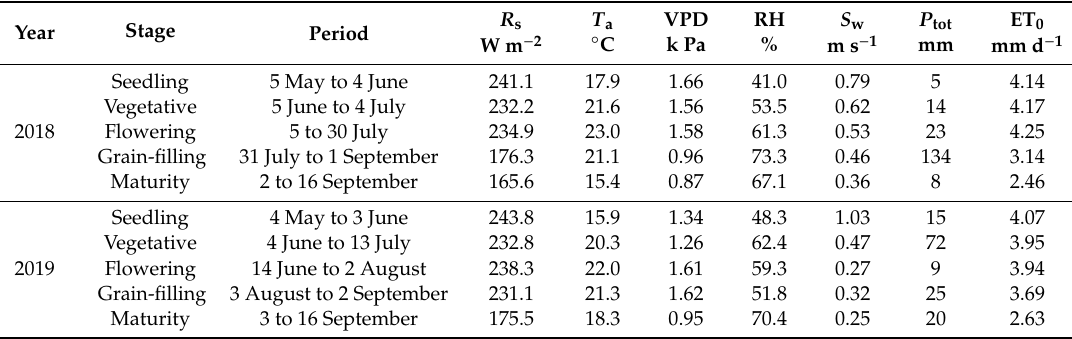
Table 3. Daily average solar radiation ( R s ), air temperature ( T a ), relative humidity (RH), wind speed ( S w ), vapor pressure deficit (VPD), reference evapotranspiration (ET 0 ), and total precipitation ( P tot ) at all growth stages in 2018 and